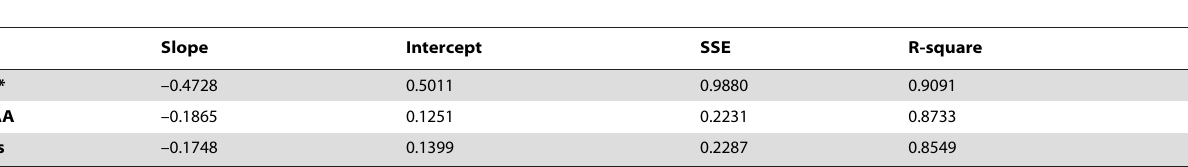
Table 2. Results of least squares fitting between base, codon, and amino acid frequencies and the genomic GC